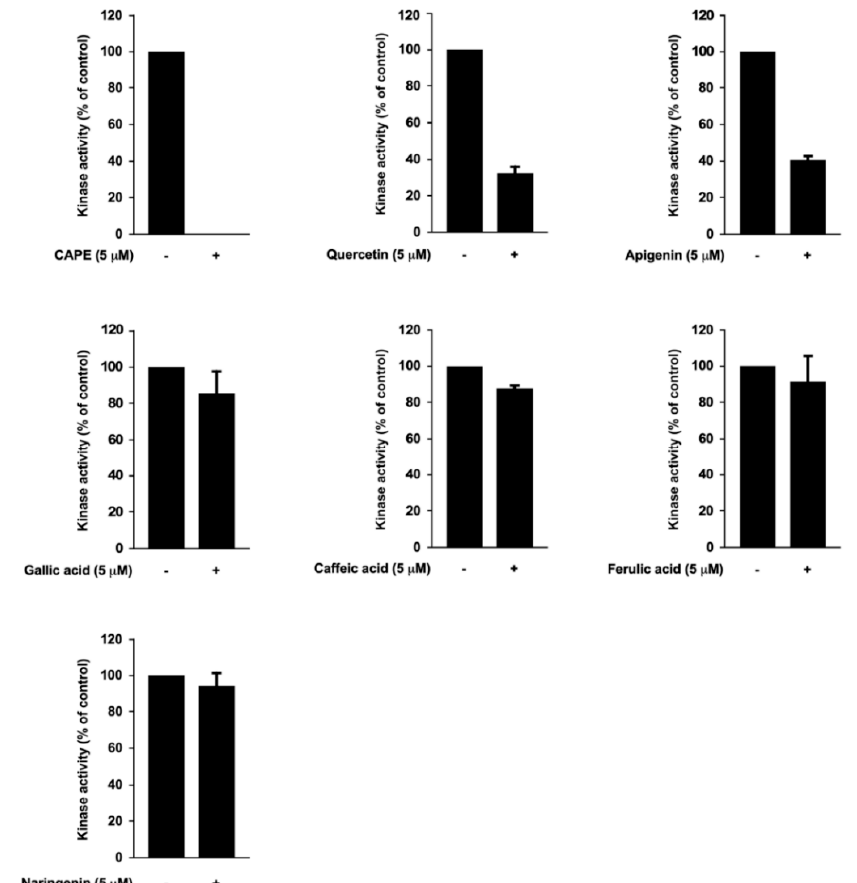
Figure 5. Di ff erential inhibitory activity of propolis compounds against phosphoinositide 3-kinase (PI3K). E ff ects of ca ff eic acid phenethyl ester (CAPE), quercetin, apigenin, gallic acid, ca ff eic acid, ferulic acid, and naringenin on PI3K activity are shown. All compounds were treated at 5 µ M. Data are shown as mean ±